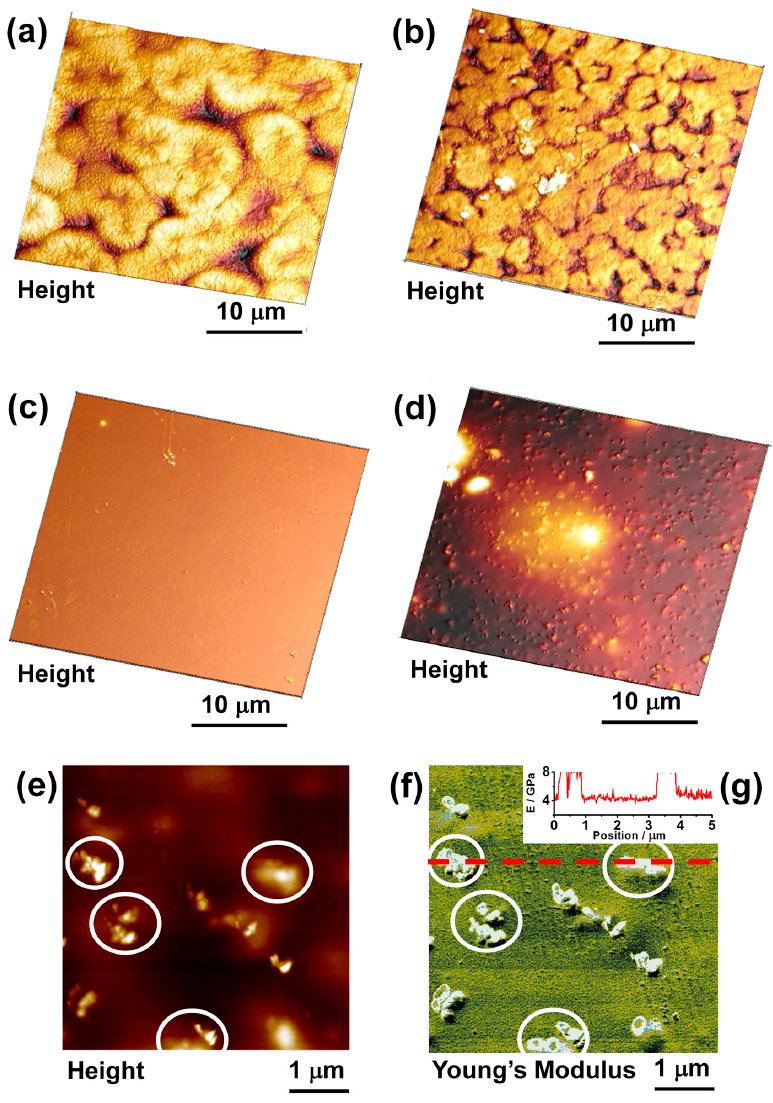
Figure 5. 3D models of surface topography of ( a ) TPEQ-ODPA; ( b ) TPEQ-ODPA-S; ( c ) PMDA-ODA; and ( d ) PMDA-ODA-S obtained from AFM measurements. ( e ) Detailed topography and ( f ) map of Young’s modulus for the same area of the surface of the PMDA-ODA-S mixed matrix membrane. ( g ) Profile of the Young’s modulus data for PDMA-ODA-S at the location indicated with a dotted line in ( f ). Color schemes for images ( a – e ) were adjusted to highlight morphological features of each sample, while equal dimensionality by X - Y - Z axes provides a realistic representation of the surfaces.